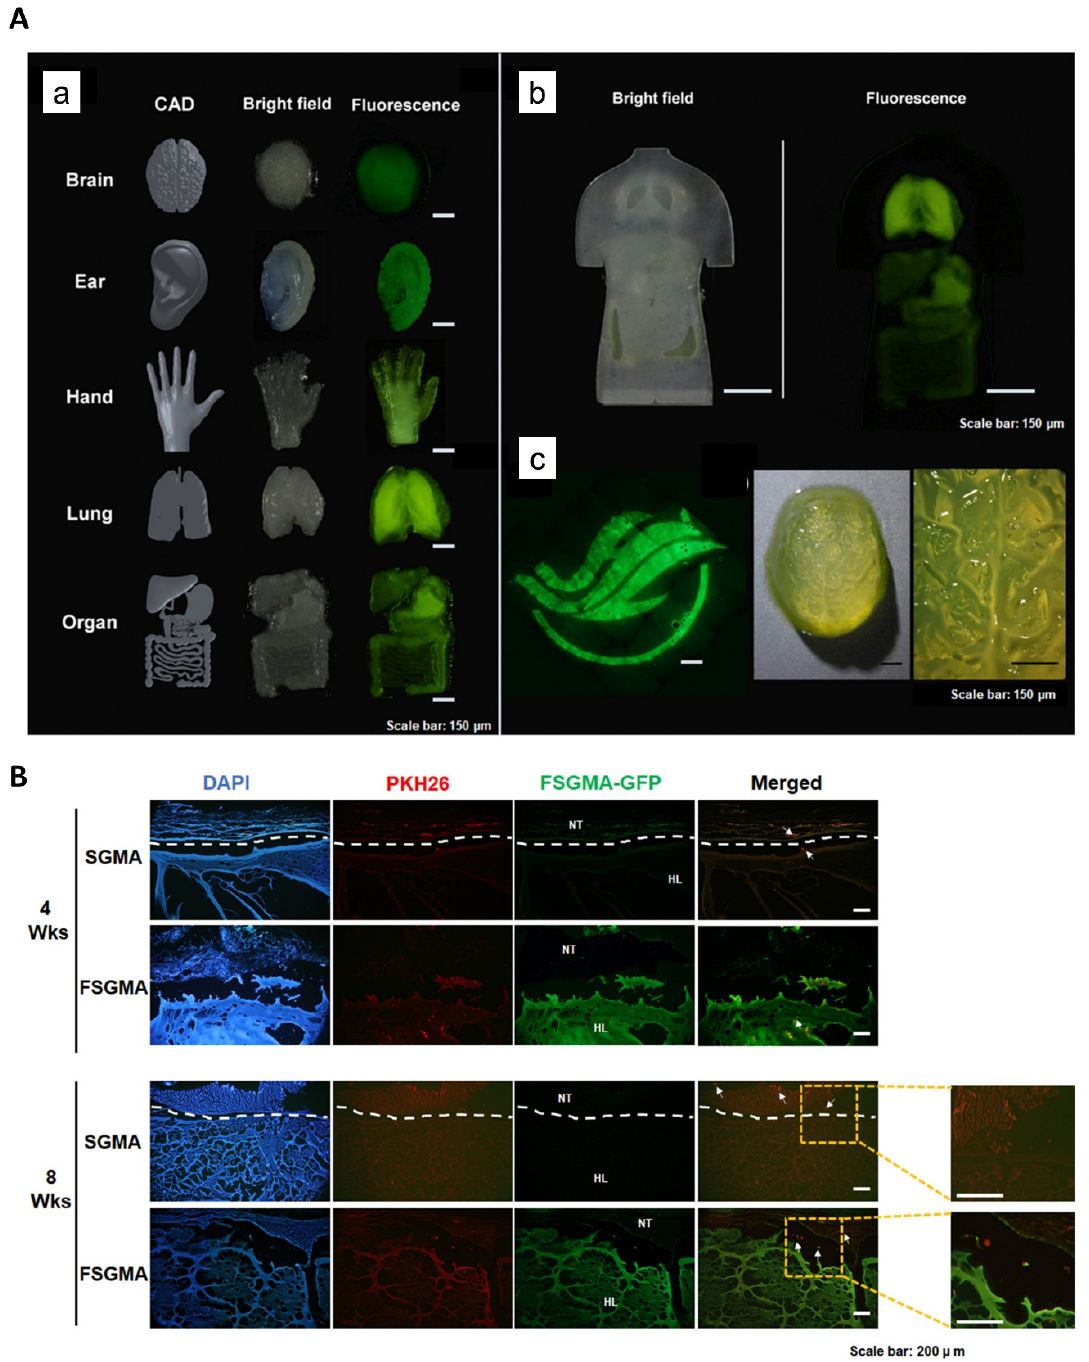
Figure 8. Printability test and FSGMA bio-ink for in vivo cell tracking. ( A ) FSGMA bio-ink’s printability. ( a ) The human brain, ear, hand, lung, and organs under bright and fluorescent fields. ( b ) Human trunk was printed with photocurable resin, and the internal organs were printed with FSGMA using DLP printer. Left side (bright field) and right side (fluorescence field). ( c ) Fluorescent image of the Hallym University logo and a mini human brain constructed using FSGMA. Scale bars present 150 μ m. ( B ) Histological study of the FSGMA and SGMA hydrogel-encapsulated PKH26- tagged NIH3T3 cells. NT: native tissue and HL: hydrogel. White arrows indicate the presence of cell movement. Adapted from [114] with permission from Elsevier.